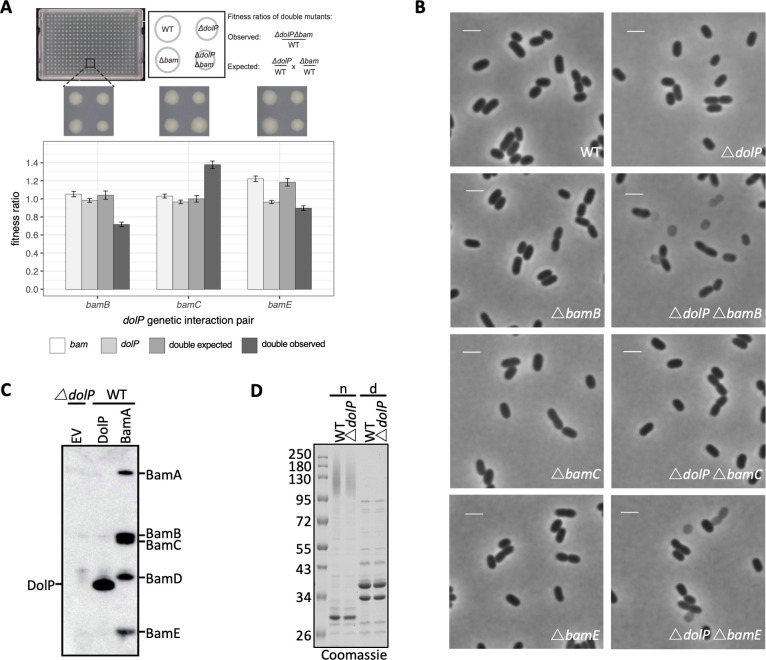
dolP has genetic interactions with bamB and bamE but no detectable physical interaction.(A) dolP genetically interacts with the genes encoding the non-essential BAM complex accessory lipoproteins. Strains were arrayed on LB Lennox agar plates using a Biomatrix six replicator. Genetic interaction plates were incubated for 12 hr at 37°C and imaged. An example of a 384‐well plate is shown above the graph. Each plate contained a total of 384 colonies consisting of 96 wildtype, single, and double mutant clones. Fitness was measured by quantifying colony size and integral opacity, which represents colony density, using the image analysis software Iris (Kritikos et al., 2017). Bar plots show the averaged values 96 technical replicates. The error bars represent the 95% confidence interval. (B) Phase contrast microscopy of WT, ΔdolP, ΔbamB, ΔbamC, ΔbamE, ΔbamBΔdolP, ΔbamCΔdolP and ΔbamEΔdolP cells after growth to mid-exponential phase (OD600 ~0.4–0.8). Scale bars represent 2 μM. Phase light cells can be observed for the ΔbamBΔdolP and ΔbamEΔdolP cells.( C) DolP immunoprecipitation. Whole cell triton X-100 solubilised lysates of E. coli BW25113 pDolPpelB, pBamA-His, and ΔdolP, were purified by Ni-NTA affinity chromatography then detected by western blot using anti-DolP and BamA-E antibodies. (D) Purified OM samples from E. coli BW25113 parent (WT) or ΔdolP cells were separated by SDS-PAGE, with (d) and without (n) boiling before being visualised by staining with coomassie.Figure 3—figure supplement 1—source data 1.Genetic interactions with DolP.